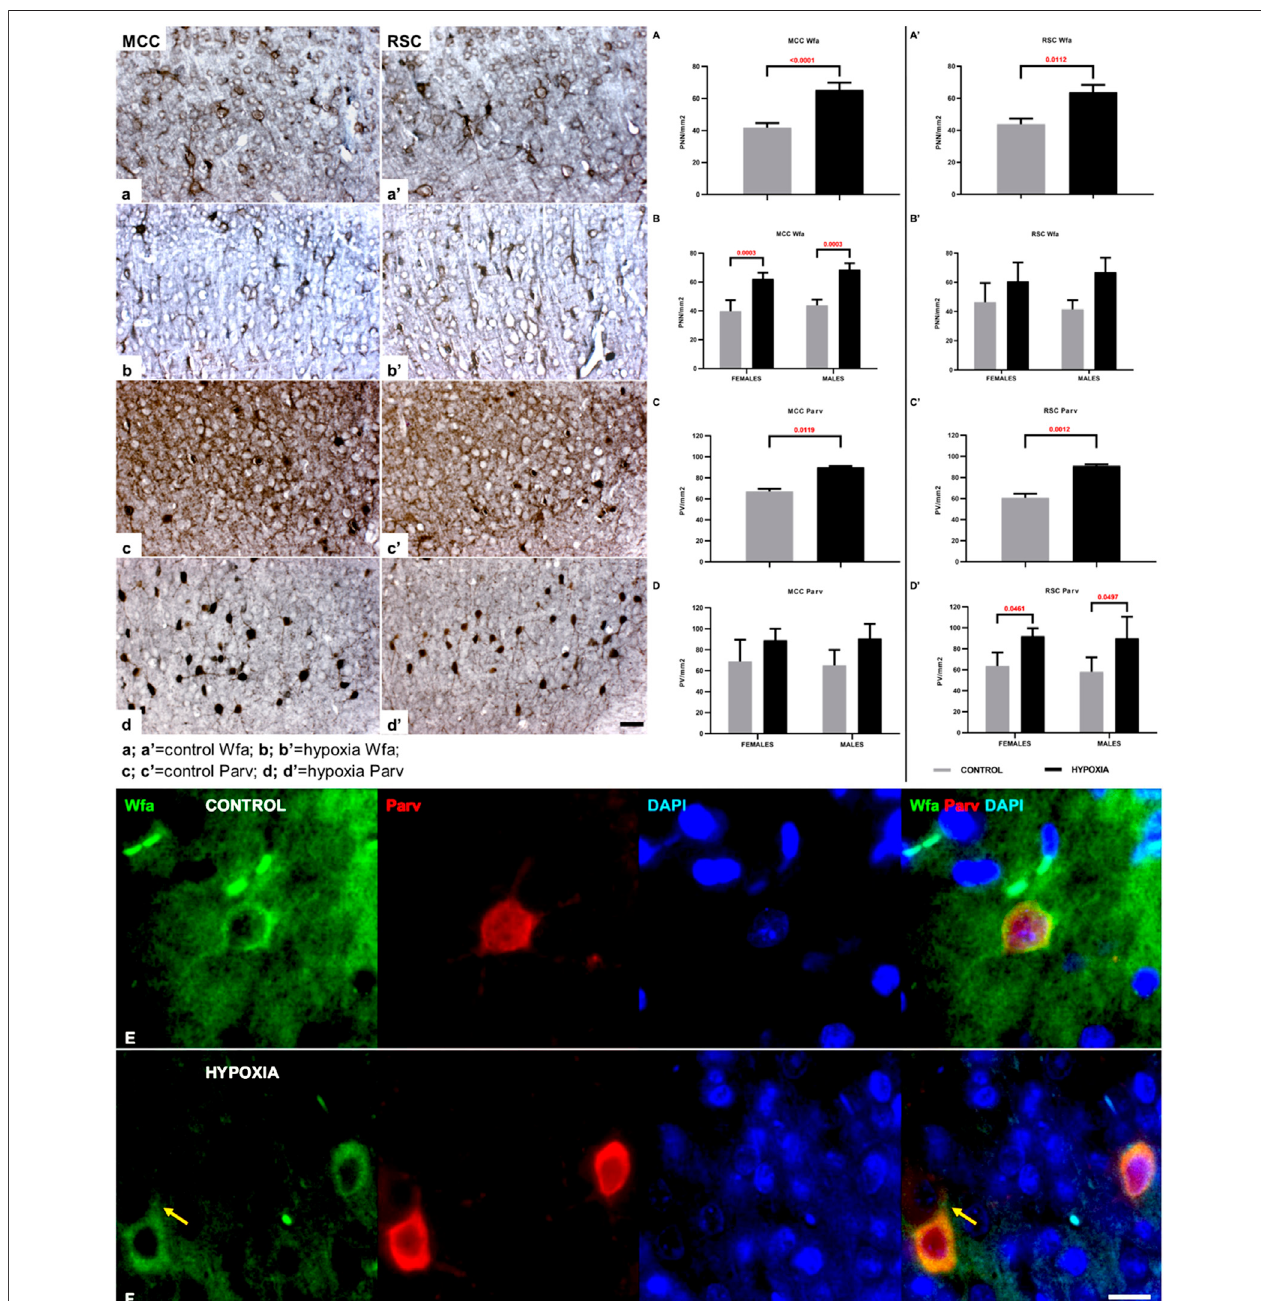
FIGURE6| Thequalitativeandquantitativedifferencesinperineuronalnets(PNN)andparvalbumin-positiveinterneurons(PV)betweencontrolandhypoxia-treated animalsattheageof3.5 monthscon fi rmapermanent structuralchangeintheconnectivityofthecingulatecortex. (a – b ’ ,A – B ’ ) Highmagni fi cationofcorticallayersIII-Va ofMCC (a,b) ,corticallayersIII-VaofRSC (a ’ ,b ’ ) ,bothstainedbyWfa,andquantitative fi ndingsforthenumberofPNNinallcorticallayersofMCC (A,B) andRSC (A ’ ,B ’ ) . The PNN are more numerous in hypoxia-treated animals in both cingulate areas. The Wfa staining of PNN is denser and thicker around the soma and proximal portion of the dendrites after perinatal hypoxia (b,b ’ ) compared to controls (a,a ’ ) . (A – B ’ ) Two-way ANOVA revealed a signi fi cant in fl uence of hypoxia on the number of PNN/mm2: (A) intheMCC (Hypoxia =F (1.12)= 72.46; p < 0.0001; Sex=F(1.12) =3.641; p =0.0806; Interaction = F(1.12) =0.1863; p =0.6736), and (A ’ ) intheRSC area (Hypoxia= F (1.9) = 10.11; p = 0.0112; Sex =F (1.9) = 0.01477; p =0.9059; Interaction= F (1.9) = 0.7814; p = 0.3997). The hypoxia-treated animals of both sexes hadasigni fi cantlyhighernumberofPNNintheMCCarea (B) ,andthesame,butinsigni fi cant,trendwasobservedinRSCarea (B ’ ) . (c – d ’ ) Highmagni fi cationoflayersIII- Va of MCC (c,c ’ ) , cortical layers III-Va of RSC (d,d ’ ) stained by parvalbumin, and quantitative fi ndings for the PV in all cortical layers of MCC (C,D) and RSC (C ’ ,D ’ ) . The interneurons soma is strongly parvalbumin - positively stained as well as the proximal portion of the dendrites in the animals subjected to perinatal hypoxia (d,d ’ ) comparedtocontrols (c,c ’ ) .Two-way ANOVA revealed asigni fi cantin fl uence ofhypoxia on thenumber ofPVper mm2: (C) intheMCC (Hypoxia =F (1.12)= 8.770; p =